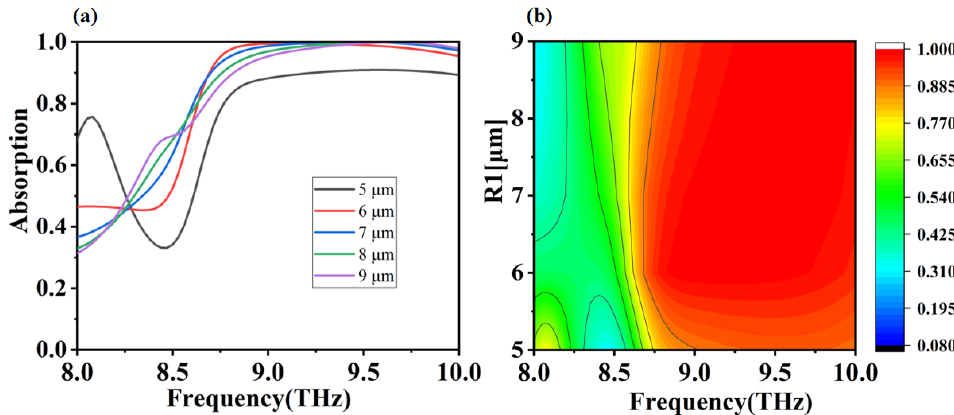
Figure 6. ( a , b ) are absorption simulation images of different disk radii R1 (5–9 µm) scanned at frequencies from 8.0 to 10.0 THz, respectively.